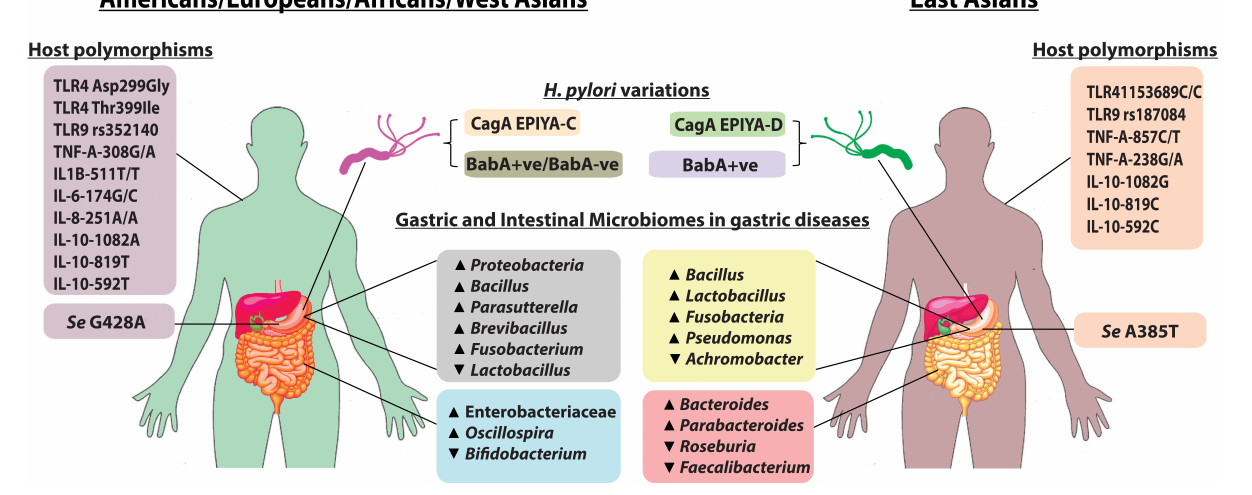
FIGURE 1 | Pattern of gastric and intestinal microbiomes, host polymorphisms, and H. pylori type between East Asia and the rest of the world: the more virulent H. pylori CagA EPIYA-D is mostly found in East Asia when compared with H. pylori CagA EPIYA-C, which is predominant in the Western world (Yamaoka, 2008). Almost all strains from East Asia express BabA, while in West, BabA-positive strains as well as a minority of BabA-negative strains are present. FUT2, encoded by the Se gene, is required for the synthesis of LeB antigen (BabA-binding host molecule). Mutations in the Se genes, Se G428A and Se A385T, are found to inactivate and to reduce the activity of FUT2, respectively (Anstee, 2010). The alteration in gastric and intestinal microbiome composition is observed in H. pylori infection, and gastric diseases also exhibit regional variations as shown in the figure. Additionally, specific host immune gene polymorphisms in different populations predispose an individual susceptibility to H. pylori colonization and gastric